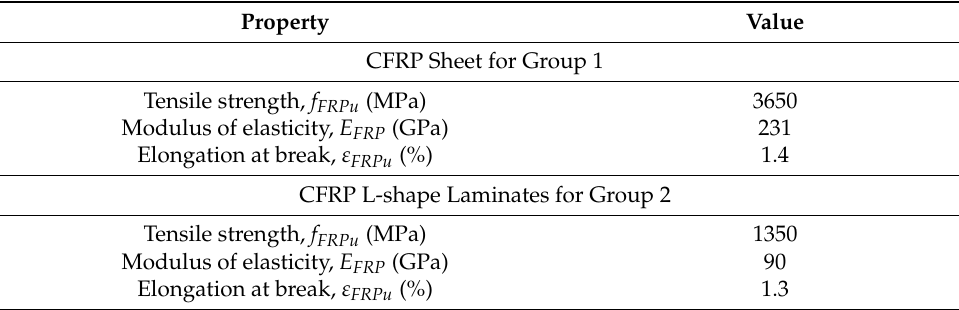
Table 4. Properties of the CFRP material